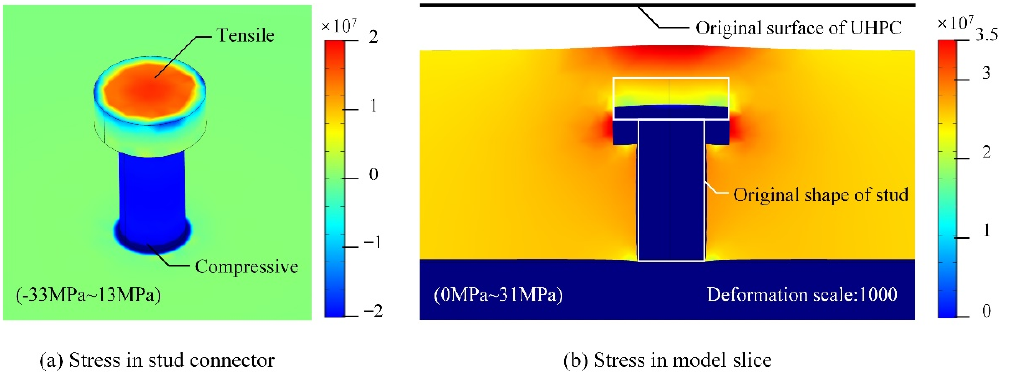
Figure 9. Detailed mechanical relationship with UHPC shrinkage and steel stud connector.